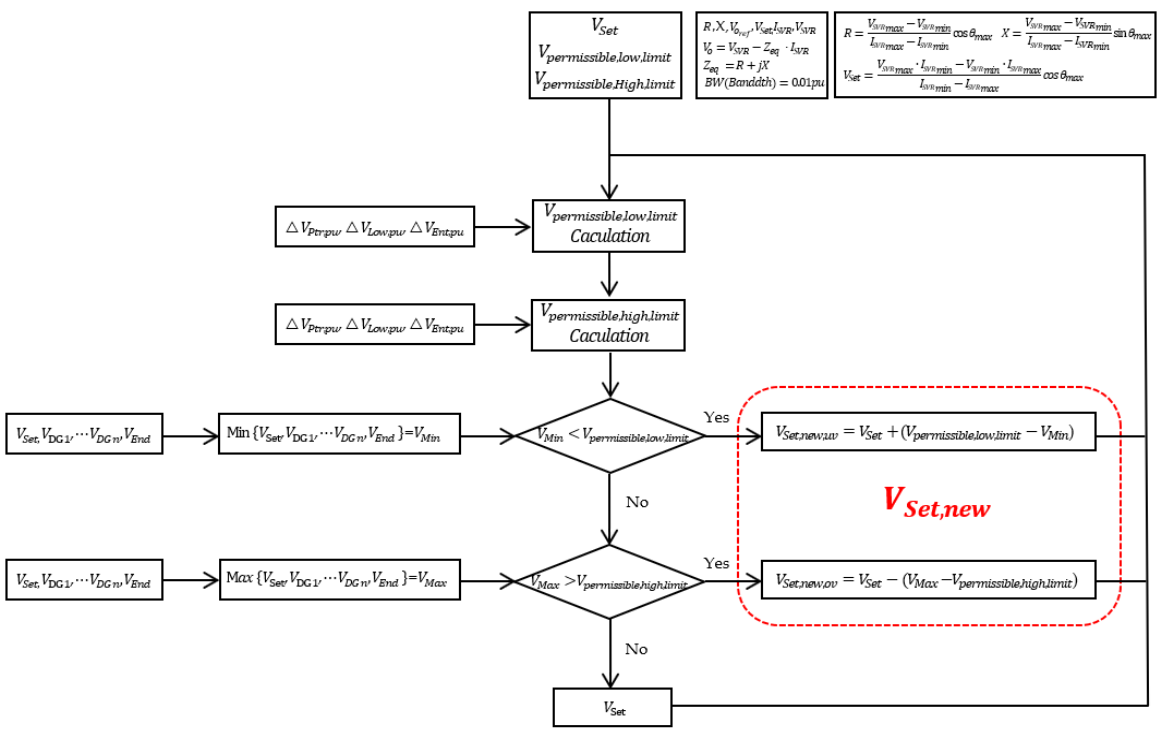
Figure 6. Proposed SVR tap-control Algorithm when reverse power flows.